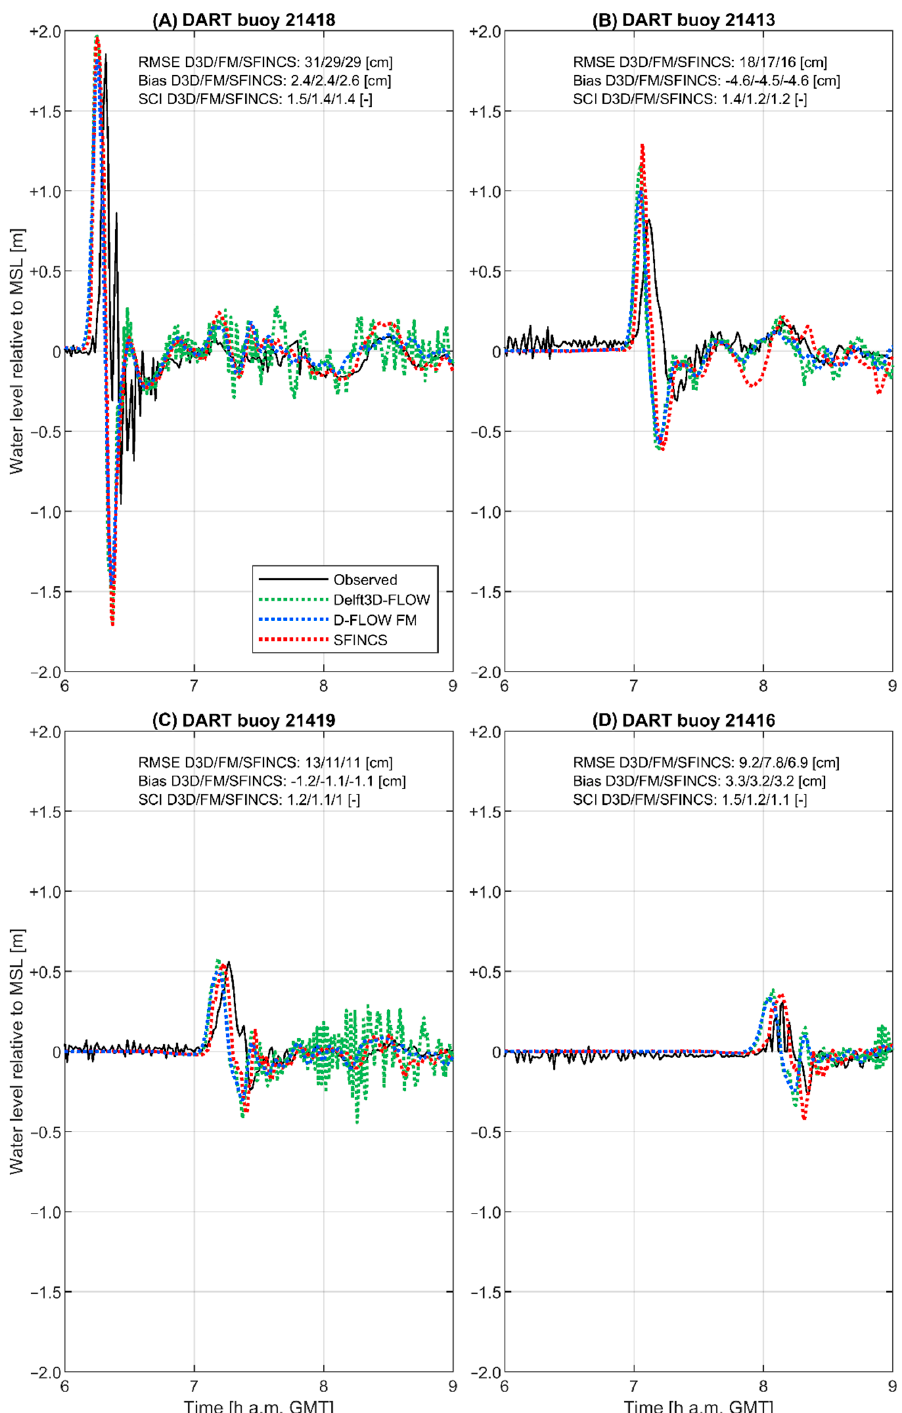
Figure 5. Comparison of the water level time-series as simulated with the Delft3D-FLOW (D3D) model (green dotted lines), D-FLOW Flexible Mesh (FM) model (blue dotted lines) and the overall SFINCS model (red dotted lines) with the water level time-series measured (black solid lines) at four DART buoys ( A – D ) in the north-western Pacific Ocean for the 2011 T ō hoku tsunami. For a quantitative comparison of the simulated and measured water levels, the statistical parameters RMSE (root mean-square error), bias and SCI (scatter index) are given for each DART buoy. The location of the DART buoys is illustrated in Figures 1A, 3A and 4A).